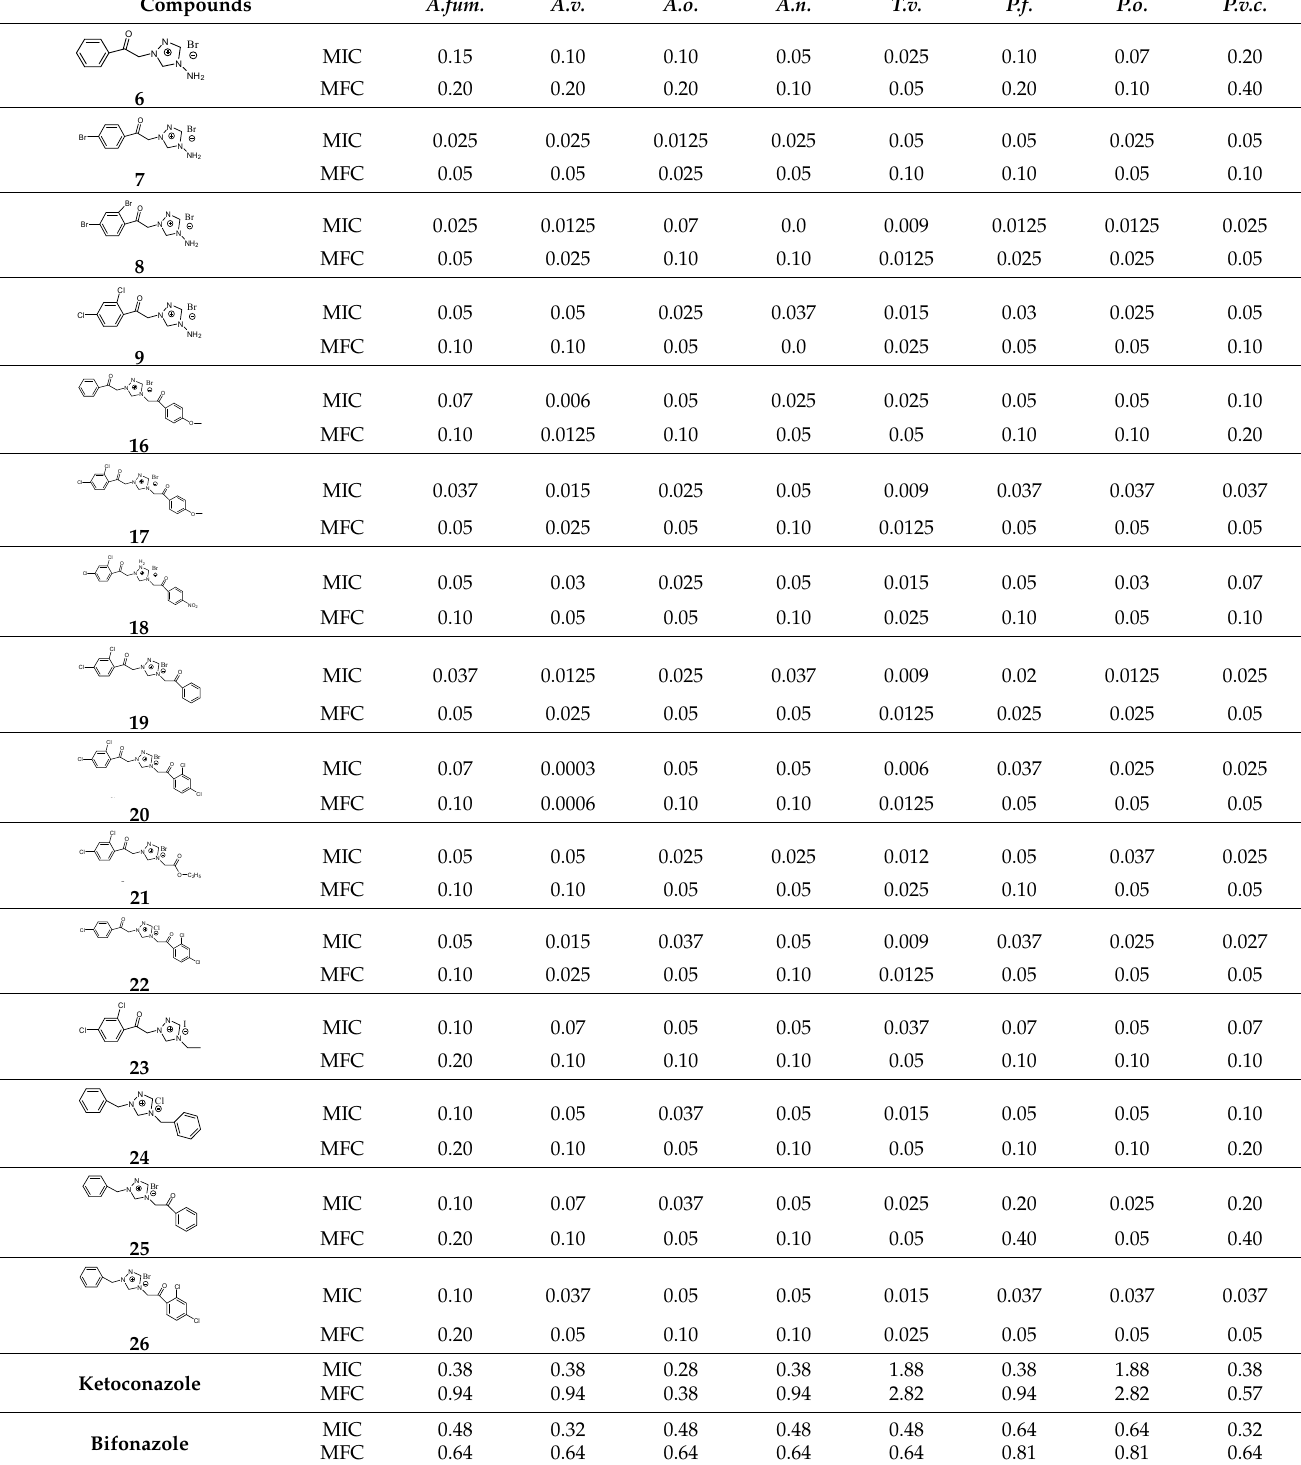
Table 1. Antifungal activity of the synthesized compound (MIC and MFC are in mg/mL).